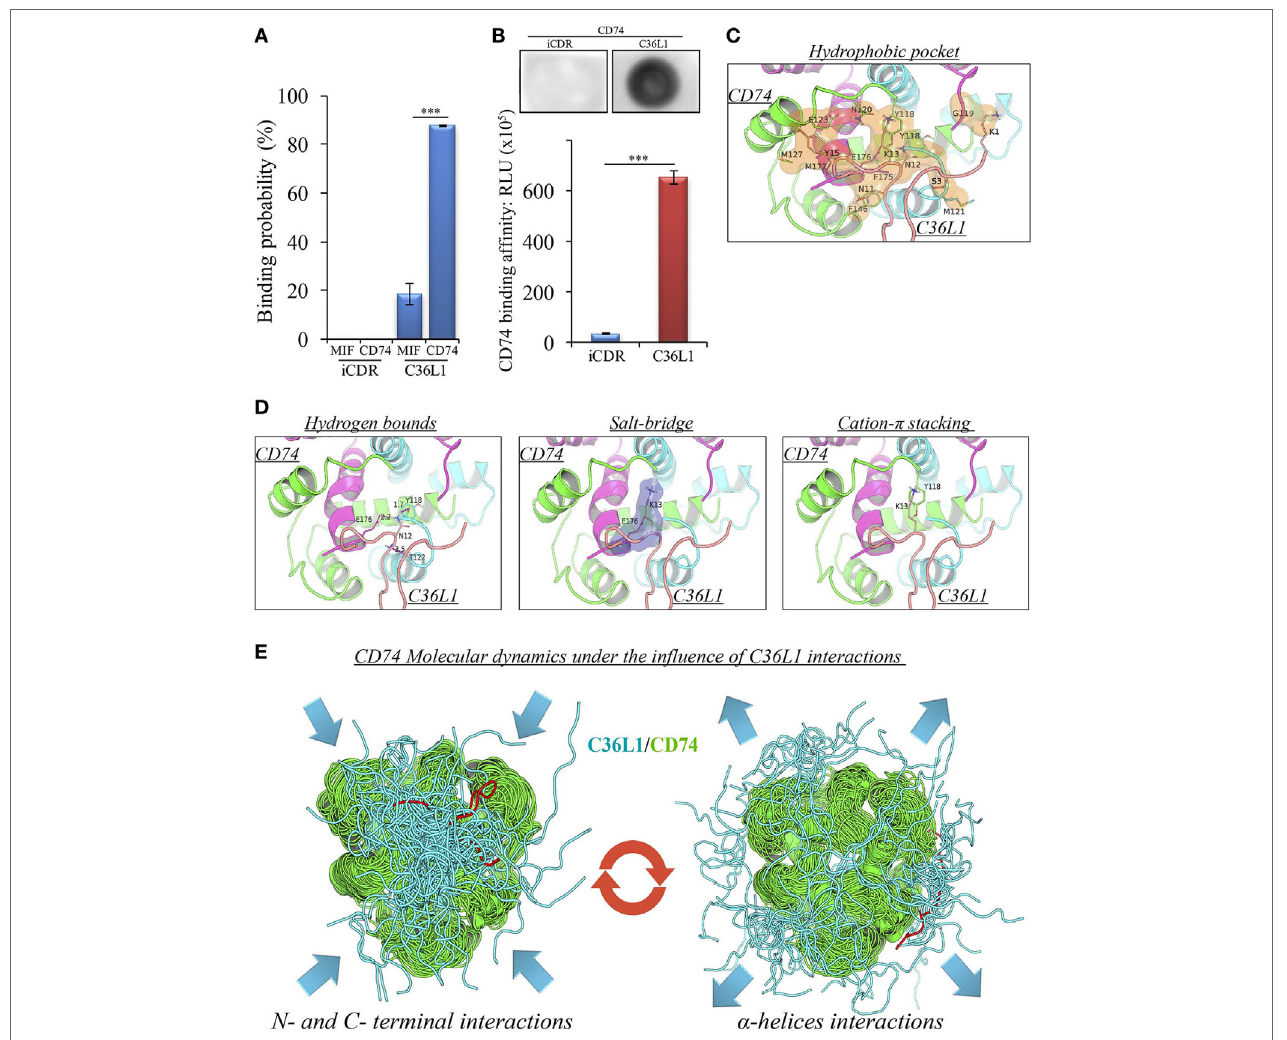
FigUre 4 | Binding prediction and molecular docking of C36L1 dynamic interactions to macrophage migration inhibitory factor (MIF) and its receptor CD74 . (a) Binding probability of C36L1 peptide and irrelevant peptide (iCDR) to MIF and its receptor CD74 calculated using PepSite algorithm. Best ranked binding scores ( n = 5) were included in the analysis for each group (*** p < 0.001). (B) Dot-blot binding assay for C36L1 and iCDR peptides to mouse recombinant CD74. Bar graph represents mean of RLU in dot area quantified using ImageJ software from triplicates ( n = 3), *** p < 0.001. (c) Hydrophobic pocket (orange) formed by CD74 and C36L1 partners characterized by carbon–carbon interactions above a 4 Å distance cutoff. (D) Electrostatic interactions between CD74 and C36L1 peptide: hydrogen bonds formed between partners. Donor–acceptor distances are described; salt bridge formed involving K13; cation– π stacking between tyrosine residues of chain A of CD74 and C36L1. CD74 chains A, B, and C are colored in green, cyan, and magenta, respectively. C36L1 is colored in yellow. (e) Overlap of highest and lowest free energy results for C36L1 (cyan) in complex with CD74 (green). Left: Overlap of the lowest free energy 50 poses showing major concentration of C36L1 peptide at the CD74 N- and C-terminal interface. Lowest peptide free energy pose highlighted in red. Right: Overlap of the lowest free energy 50 poses, where C36L1 visits other regions of CD74, including the external region of the α -helices. Lowest peptide free energy highlighted in